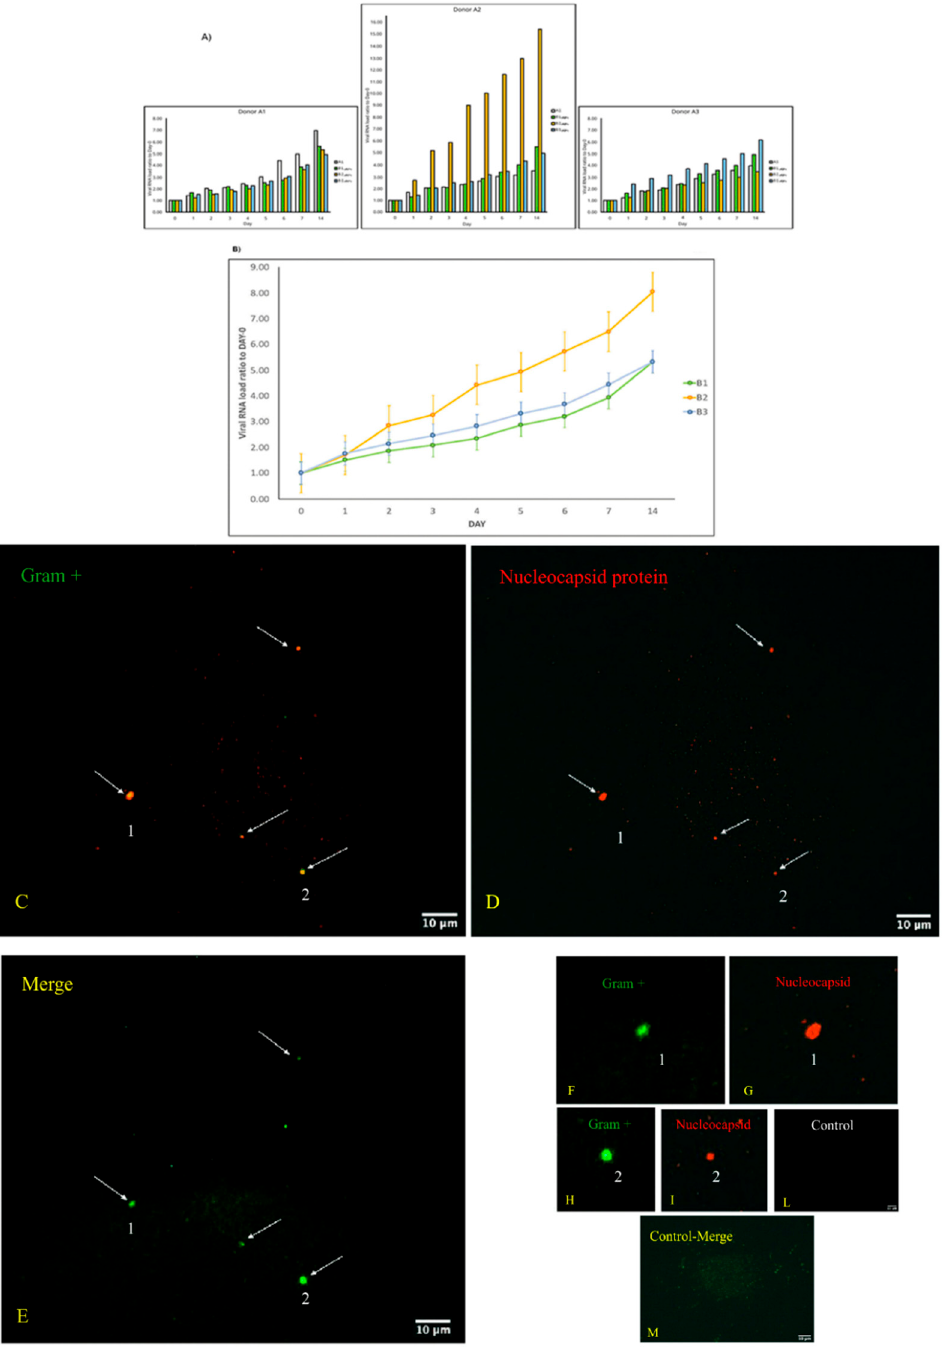
Figure 1. Panel ( A , B ): viral increase of SARS-CoV-2 in bacterial cultures. These images are reused and correspond to Figure 3 of Petrillo et al. 2021 (doi:10.12688/f1000research.52540.1.) obtained with the gentle permission of Dr. Petrillo et al., 2021 [7]. Results of experiments combining samples from three “infected donor” sources (A1–A3) and from three “healthy recipient” sources (B1–B3). ( A ) The graphs report results of nine combinations. To normalize the measurements, all values at day 0 were used as the denominator (at day 0 all values = 1), i.e., for each sample, at day X, the ratio between Luminex Count at DayX/Luminex count at day 0 was calculated. Each bar represents the SARS- CoV-2 RNA load ratio. ( B ) Each line represents the average of the SARS-CoV-2 RNA load ratio of